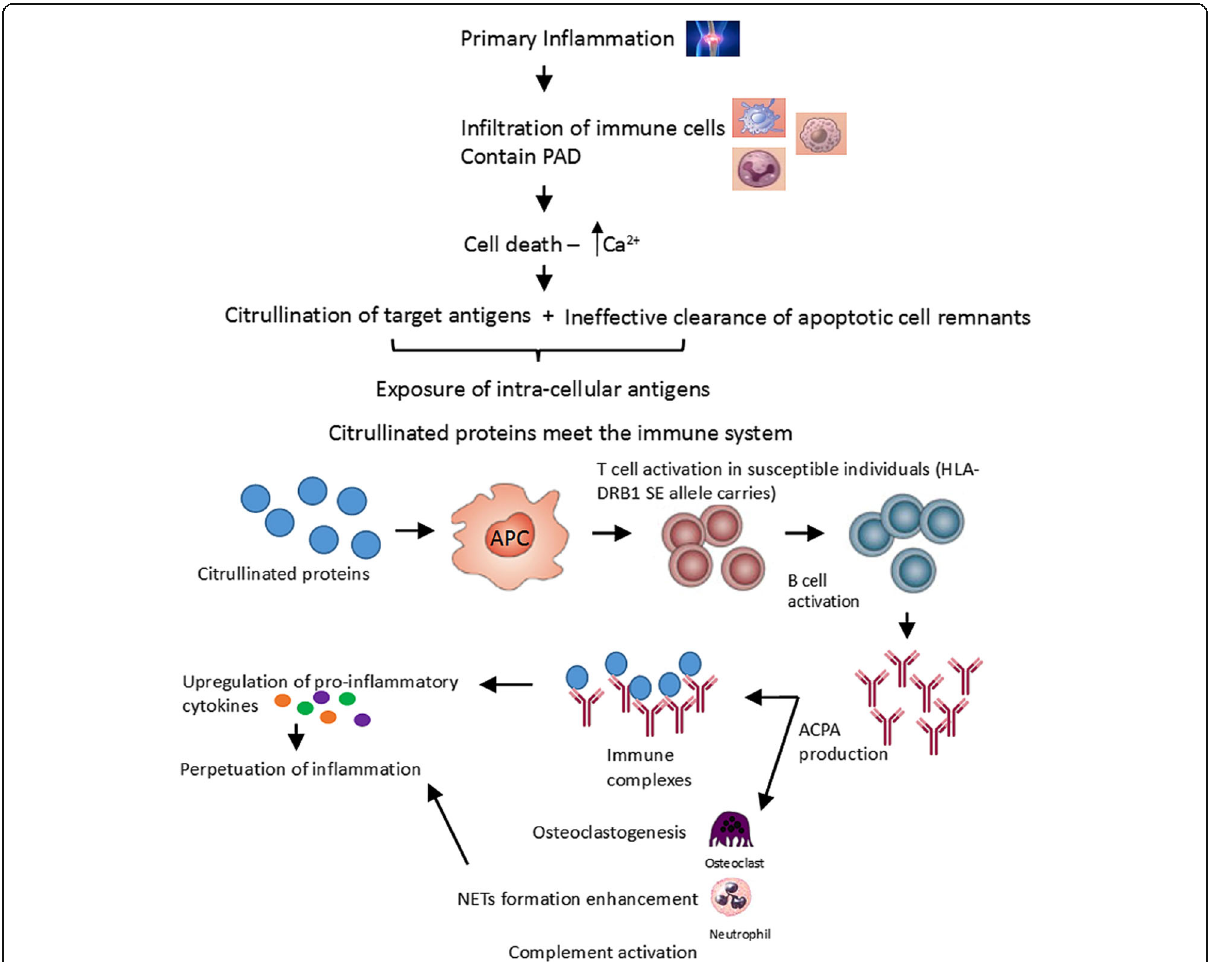
Fig. 3 Hypothetical role of citrullination in RA. Infiltration of immune cells containing PAD in inflamed tissue (joint). PAD activation due to high intracellular calcium concentration during cell death promotes citrullination of target antigens. Ineffective clearance of apoptotic cell remnants promotes prolonged accessibility of intra-cellular antigens that meet the immune system. Antigen presenting cells (APC) will process and present citrullinated peptides to T cell. In susceptible individuals, activated T cells will activate B cells to generate autoantibodies. This will ultimately result in immune complex formation, followed by upregulation of pro-inflammatory cytokines. Also, ACPA may bind to osteoclasts and thereby promote bone erosion, enhance NET formation by neutrophils and activate